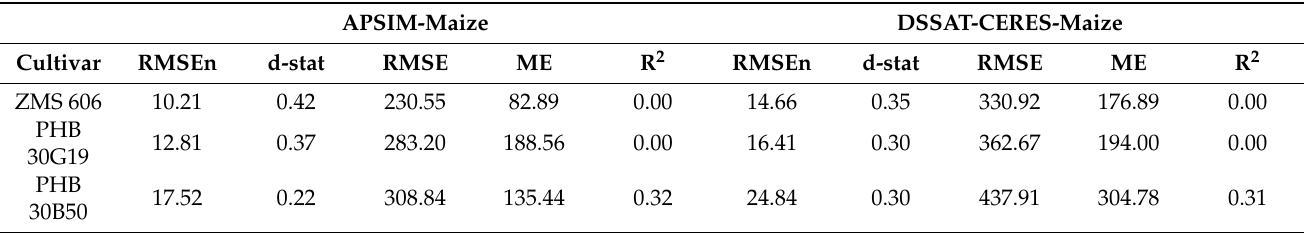
Table 11. The APSIM-Maize and DSSAT-CERES-Maize model calibration statistics for the grain number m − 2 for the maize cultivars under rainfed conditions.